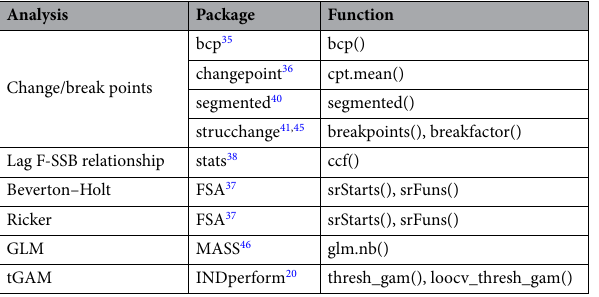
Table 2. R packages and functions used in the North Sea stocks